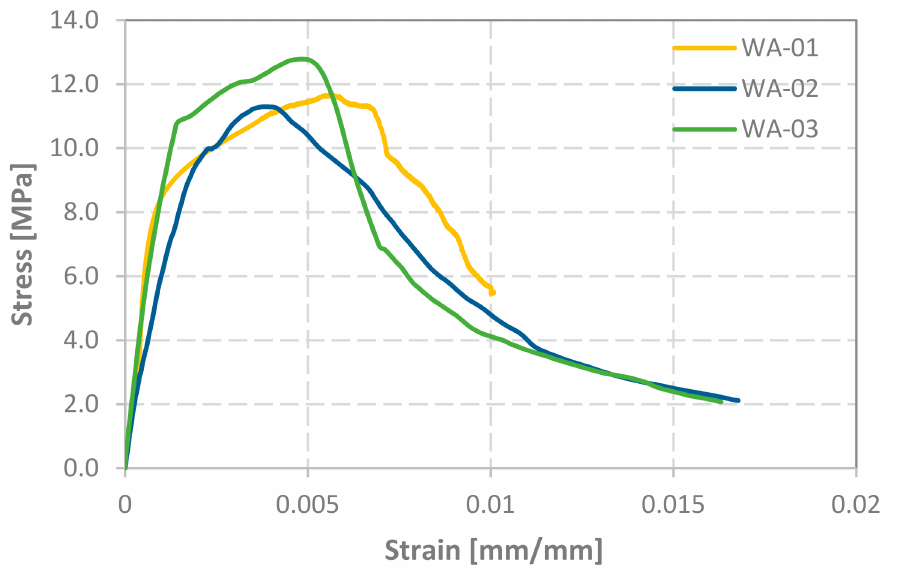
Figure 8. Stress-strain plots of axial compression test for each